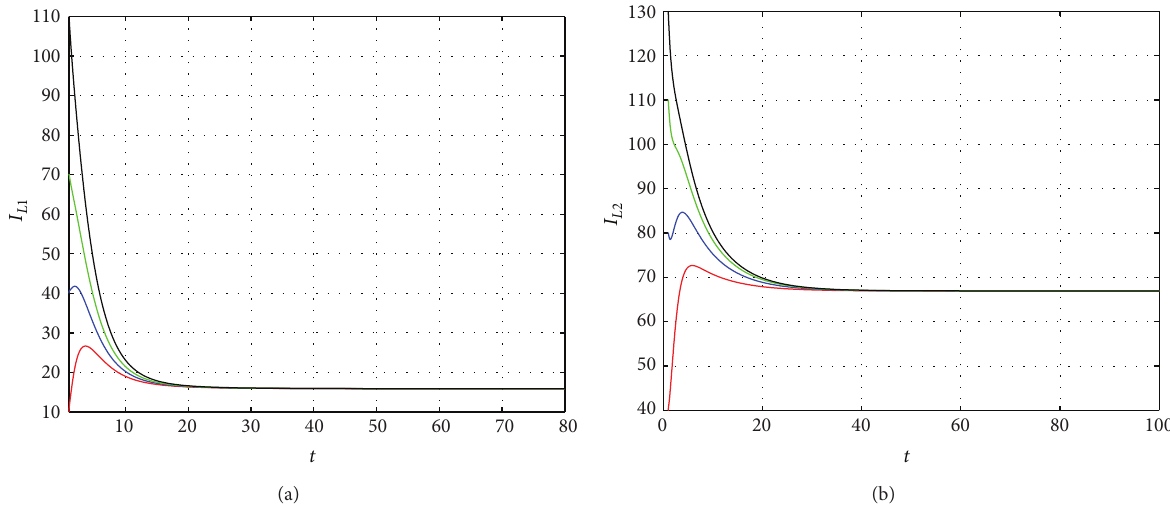
Figure 5: Time series of echinococcosis disease 𝐼 𝐿𝑖 , 𝑖 = 1,2 , when the two patches are connected with 𝐷 1 = 0.2 , 𝐷 2 = 0.8 .